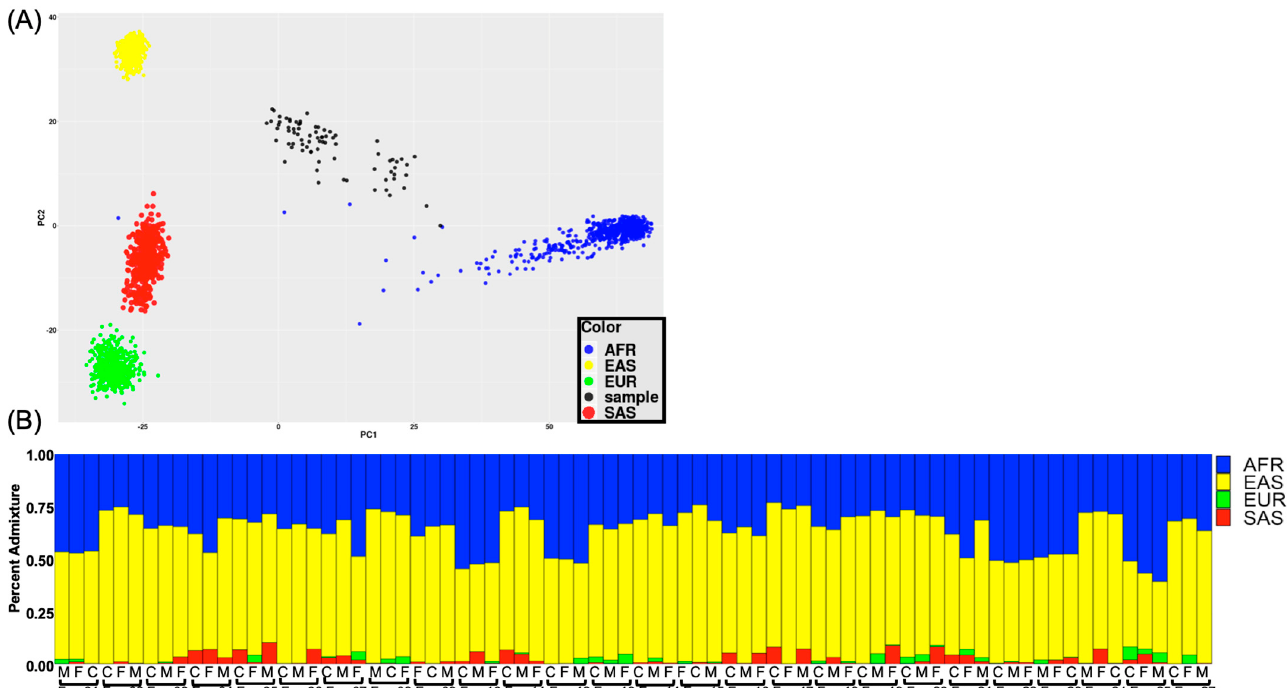
Figure 1. Population stratification defines propositions of calculated genetic ancestry. ( A ) Principal component analysis (PCA) across all subjects in this study (black dots). The European ancestry (green dots), African ancestry (blue dots), East Asian ancestry (yellow dots), and South Asian ancestry (red dots) using AIMs derived from the custom whole-exome deep sequencing and matched to 1k Genome Population Exome Phase1_v3 Genotypes. ( B ) STRUCTURE plot (K = 4; 50,000 Burn-in period and 100,000 NUMREPS) used to compute genetic ancestry percent admixture: European ancestry (green), African ancestry (blue), South Asian ancestry (red), and East Asian ancestry (yellow). Each trio family cluster contains M (mother), F (father), and C (child).